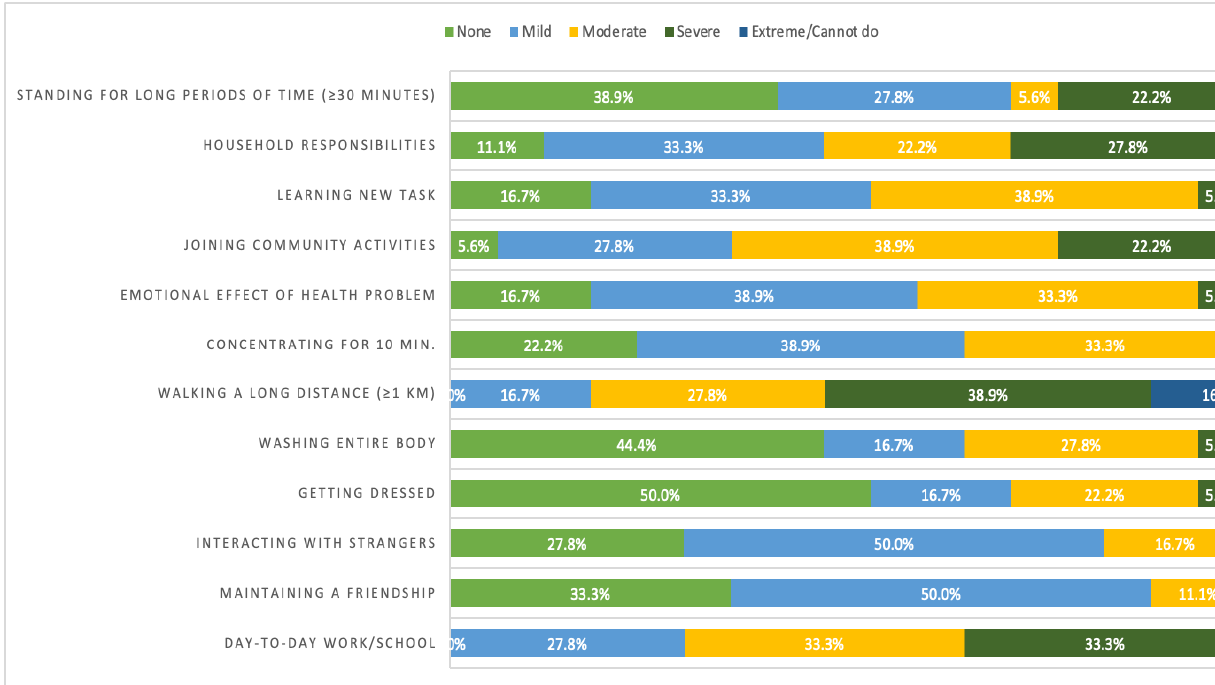
Figure 1. Self-assessment using WHODAS 2.0 12-item questionnaire.